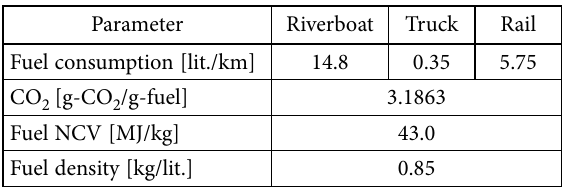
Table 4. Engine fuel parameters and CO 2